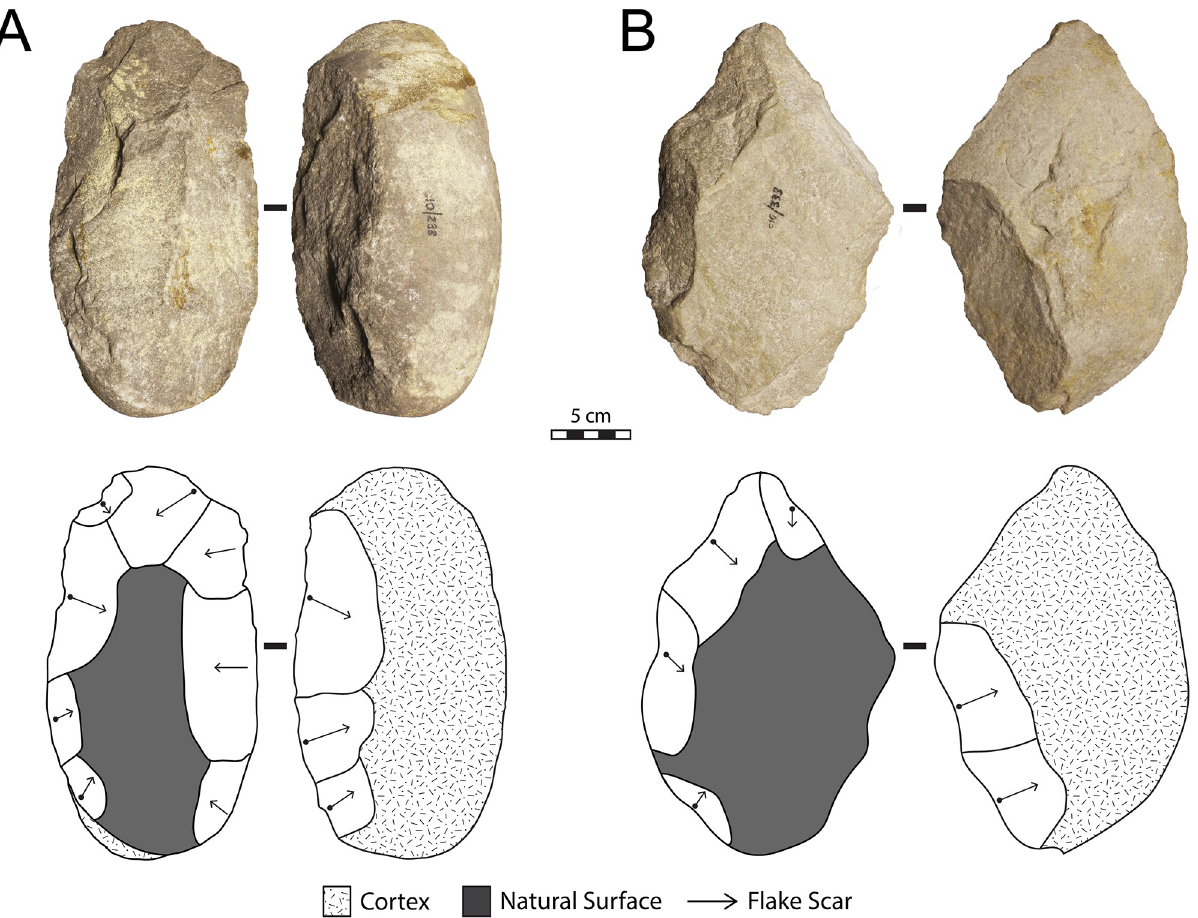
Fig 15. Two giant cores form Area 1 demonstrating the early phases of large cutting tool production. A) Naturally halved cobble exhibiting bifacial reduction related to LCT production; B) Spall exhibiting potential tip